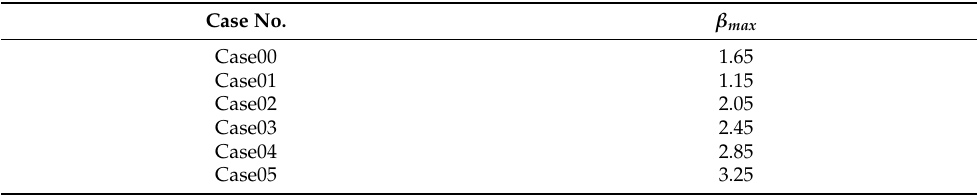
Table 1. Numerical experimental conditions of wind–wave interaction growth parameter (Repro- duced with permission from Roh et al., J. Korean Soc. Coast. Ocean Eng. ; published by J. Korean Soc. Coast. Ocean Eng. , 2020.)